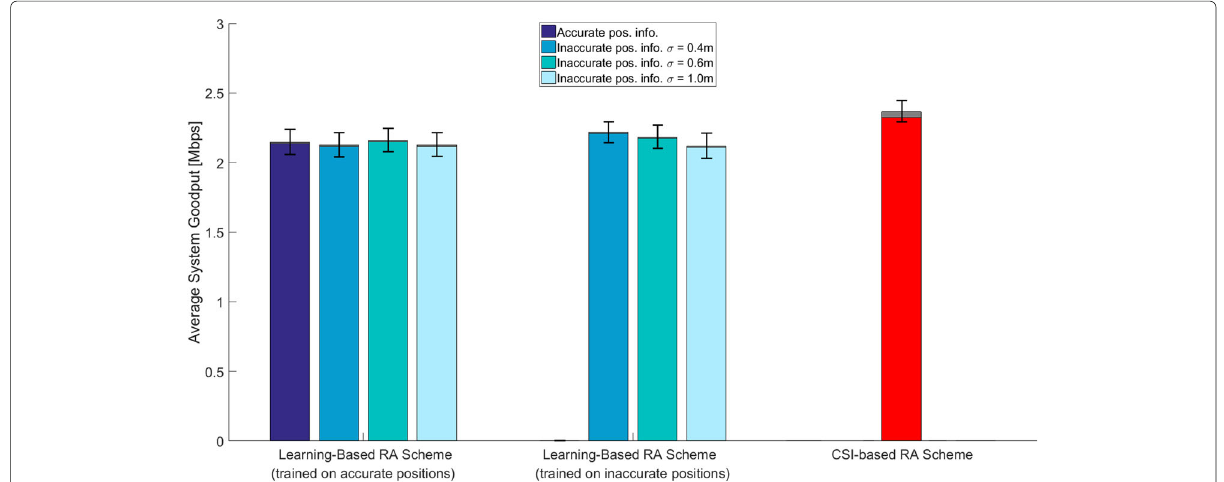
Fig. 10 Average system goodput for different schemes and various possibilities of available position information for NLOS